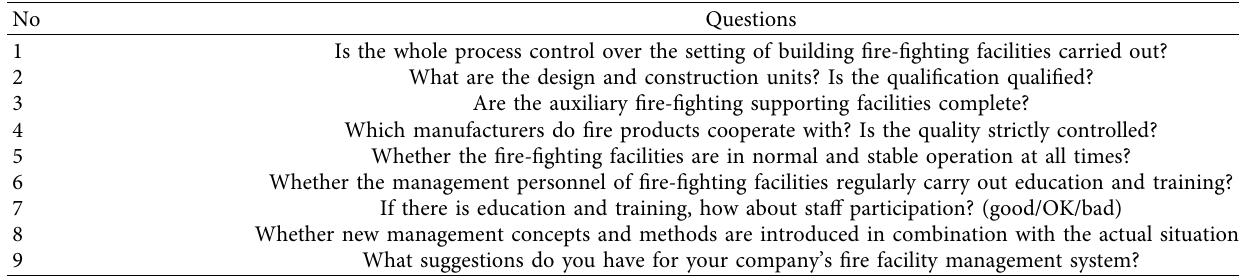
Table 18: Interview survey on traditional fre-fghting system.